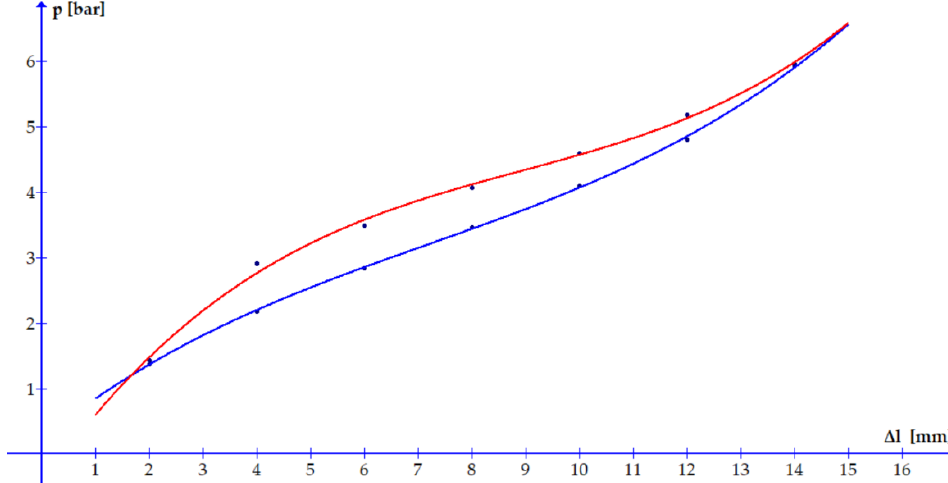
Figure 12. The evolution of the input pressure versus axial contraction (M = 2.55 kg).